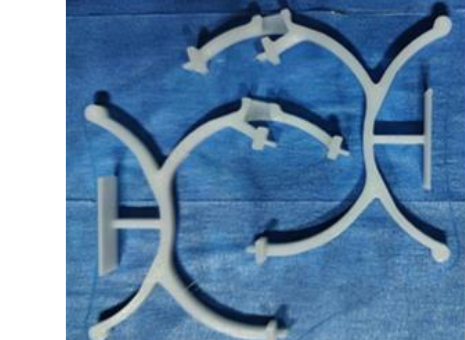
Figure 6. Obtained results for compliant mechanism with four gripping elements.